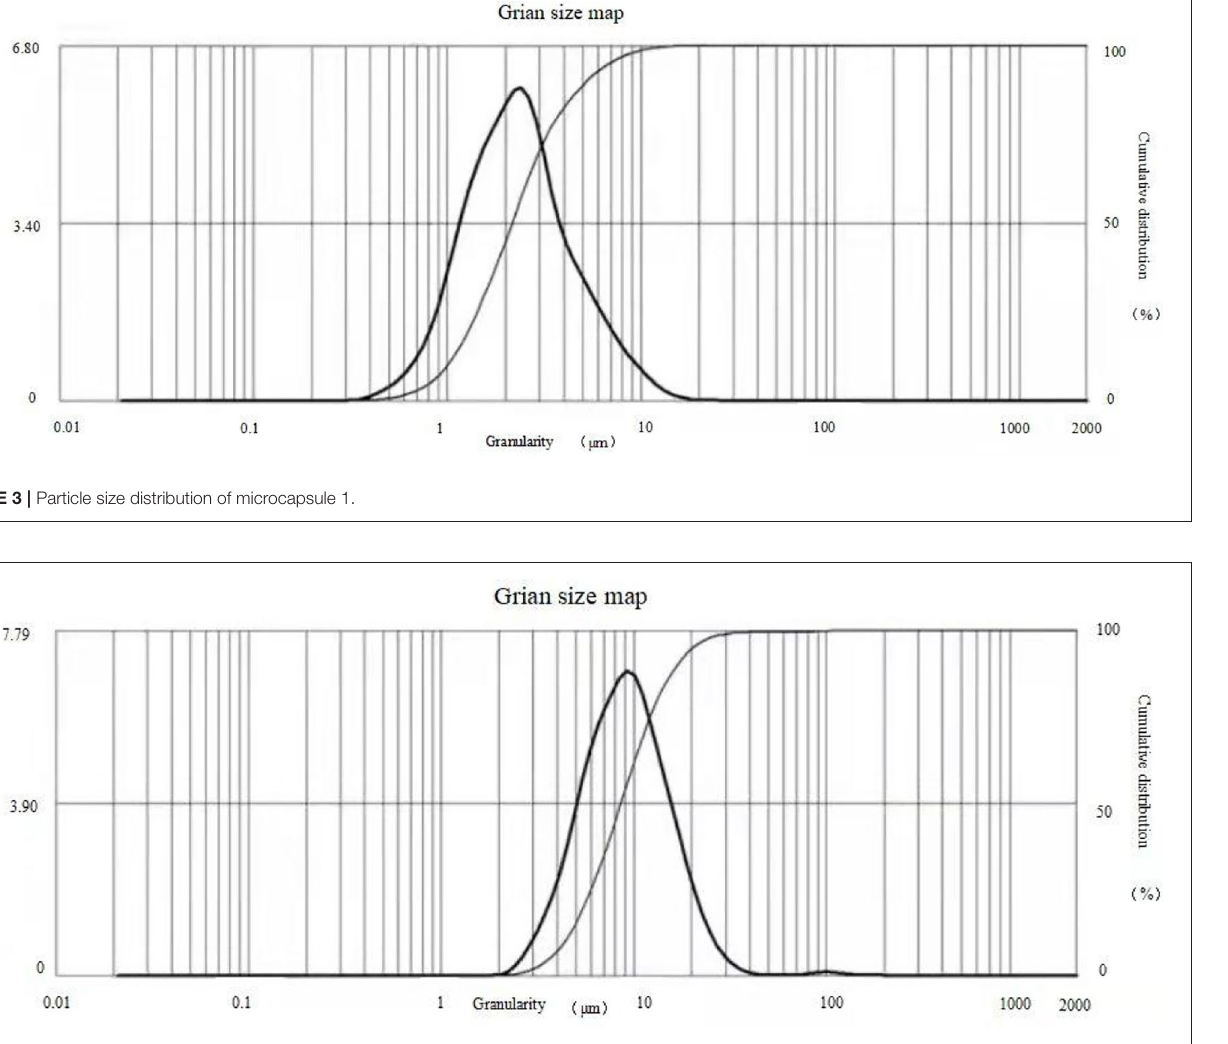
FIGURE 4 | Particle size distribution of microcapsule